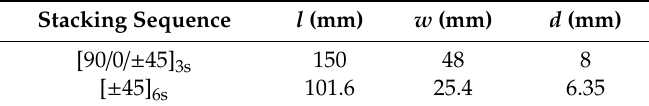
Table 3. Mechanical properties of material IM7/8552 [29].